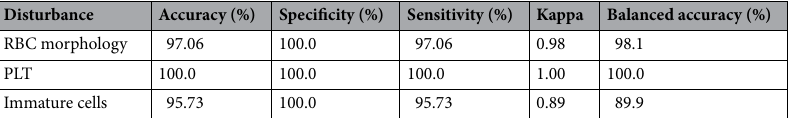
Table 3. Accuracy, specificity, sensibility, kappa coefficient, and balanced accuracy of the flagging study, comparing the Hilab system to the microscopy